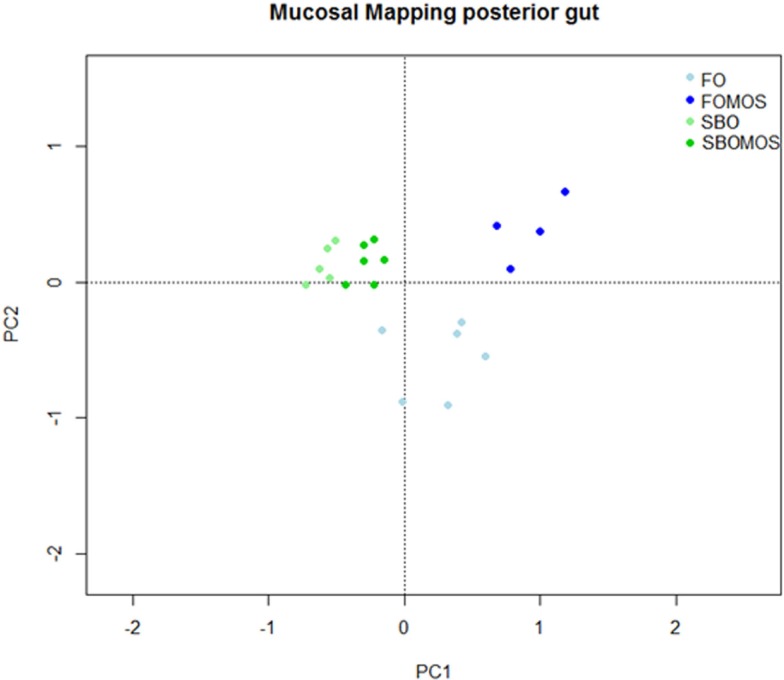
Principal component analysis (PCA) to study the variability on the posterior gut relative gene expression in relation to dietary treatment. The points correspond to the tanks and are colored according to their diet, being FO, fish oil; FOMOS, fish oil and MOS; SBO, soybean oil; SBOMOS, soybean oil and MOS.